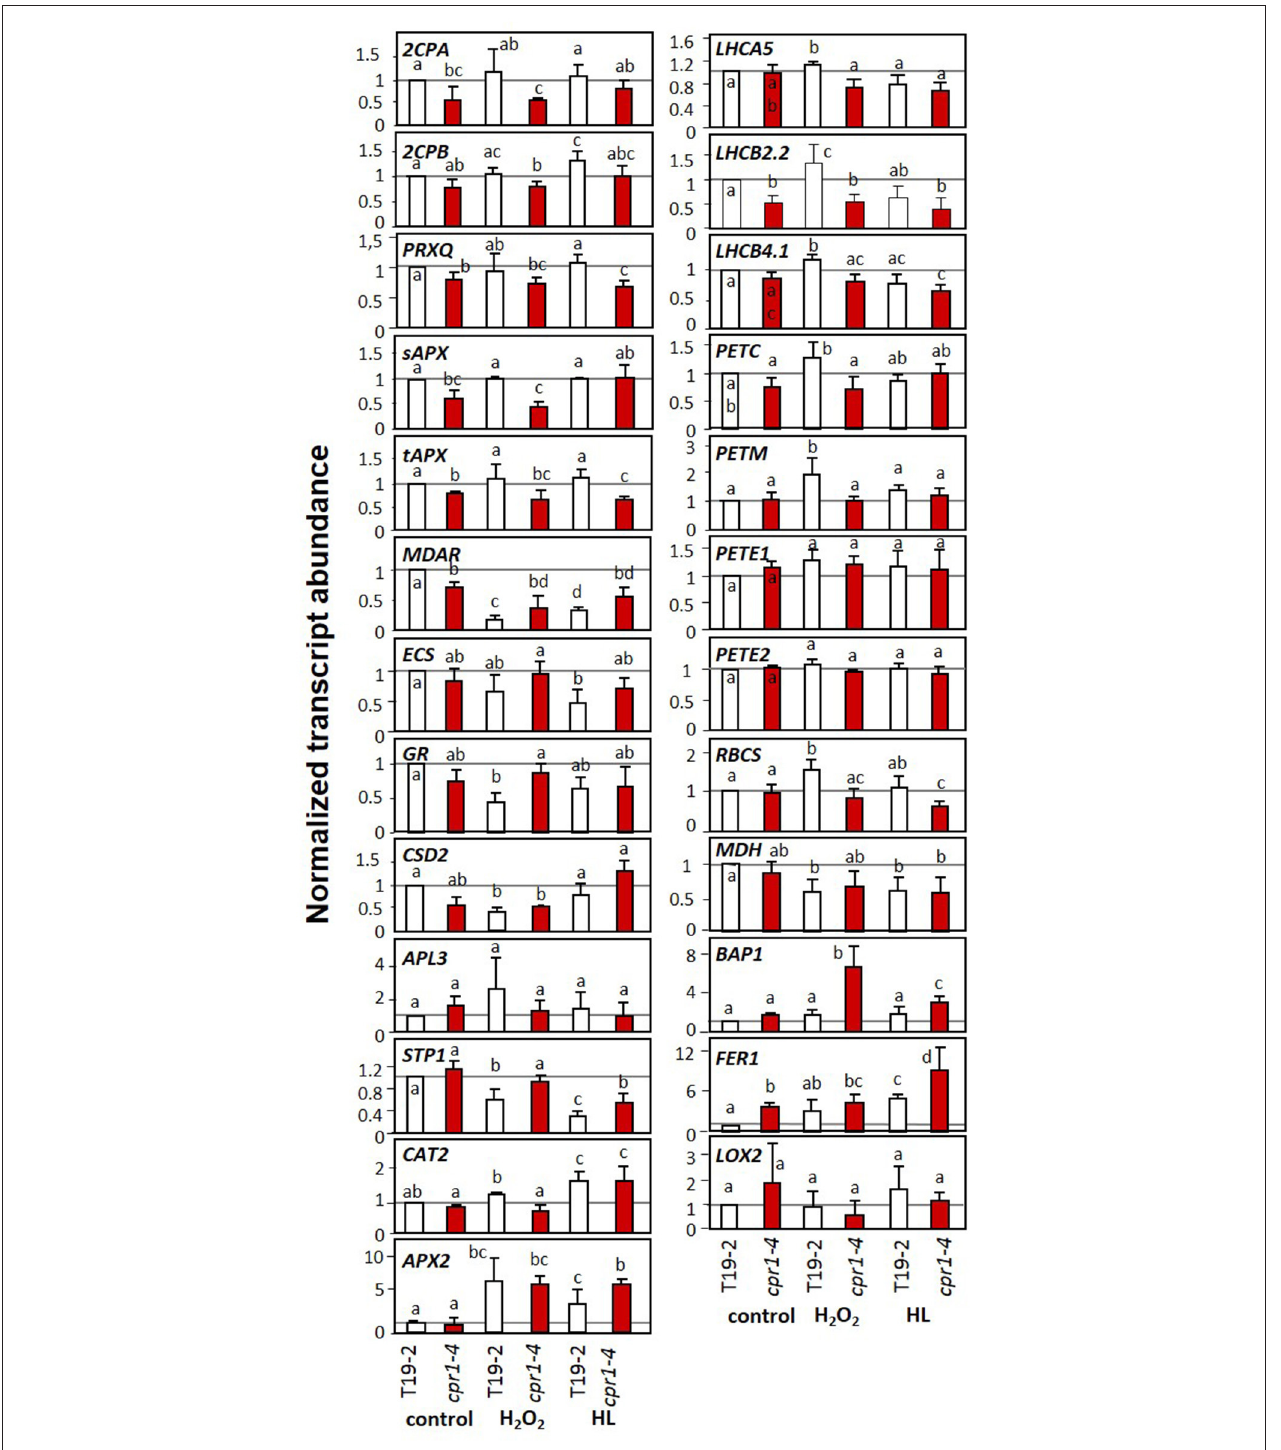
FIGURE 7 | Transcript levels of genes encoding chloroplast antioxidant enzymes, photosynthetic proteins, sugar-related enzymes and marker genes for oxidative stress and wounding upon H 2 O 2 and high light (HL) treatment in 9-day-old seedlings of cpr1-4 and T19-2 grown in sterile culture. The seedlings were infiltrated with 10 mM H 2 O 2 or exposed to 800 µ mol photons m − 2 s − 1 (HL) while floating on MS-medium for 4h. Bars represent the mean and standard deviation of four to seven biological replicates by qRT-PCR and normalized to actin2 ( At3g18780) transcript levels. Statistically significant differences are indicated with different letters (ANOVA, P <